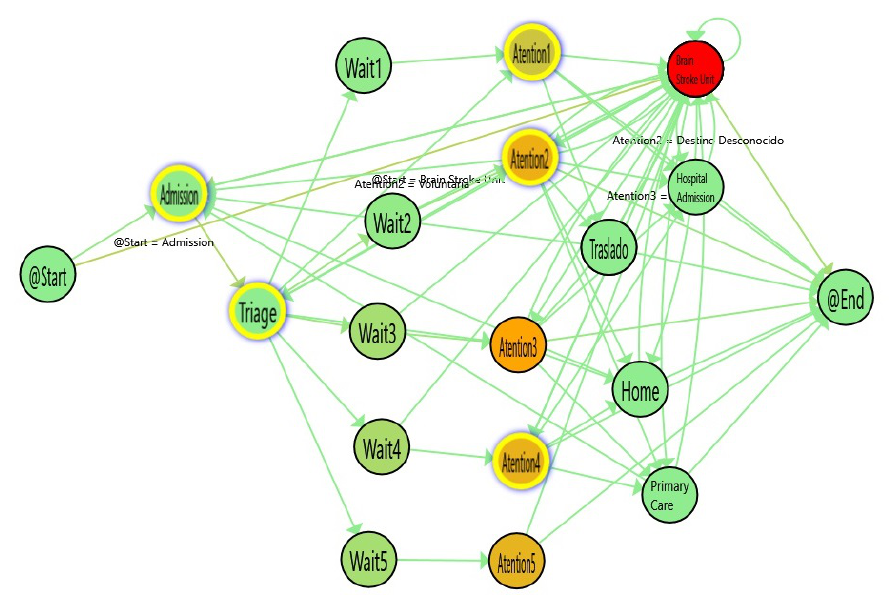
Figure 4. Flow of Stroke episodes with Statistical Significance Map. The colors in nodes represent the average time spent in each